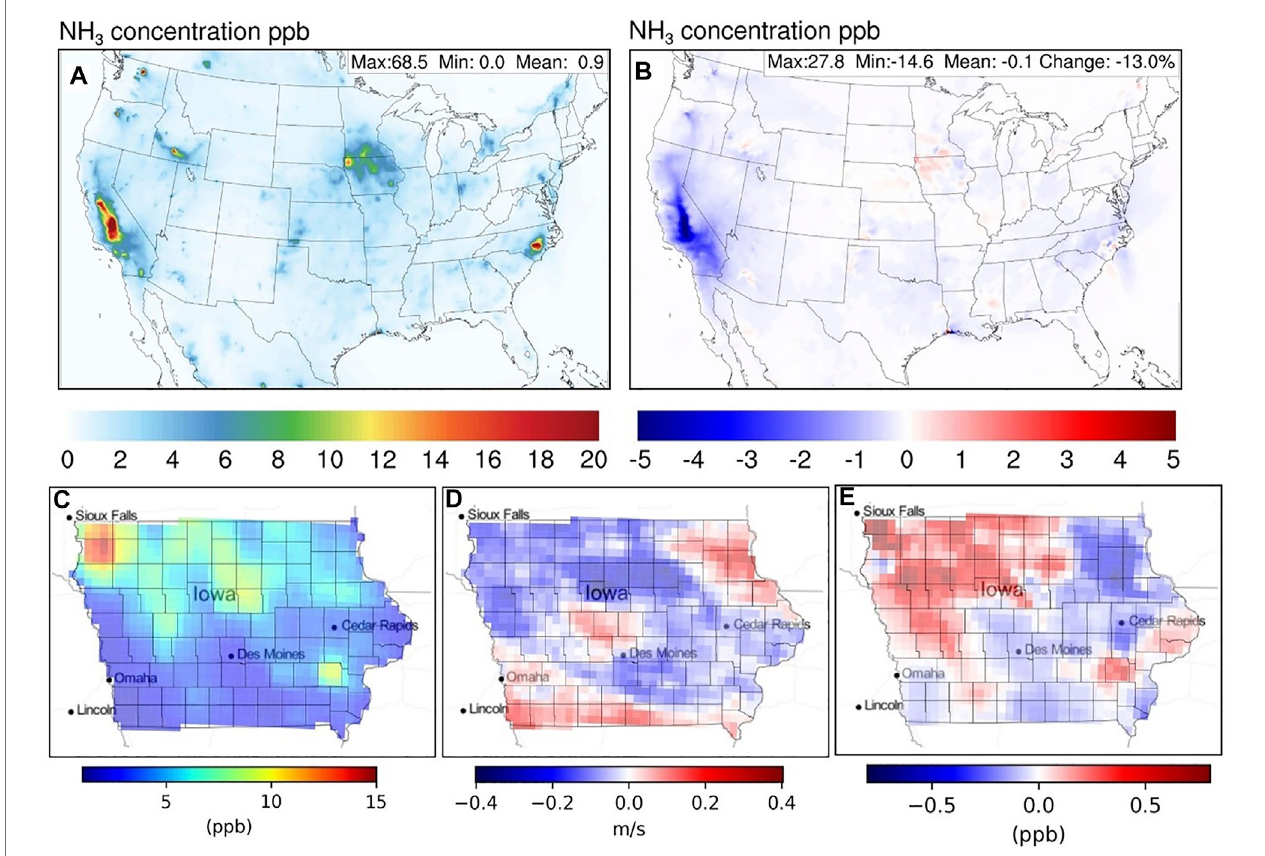
FIGURE 2 | Spatial distribution of time-averaged NH 3 concentration for Base_14 (A) CONUS and (C) State of Iowa. Spatial distribution of differences between UpTk_14 and Base_14 uptake case: (B) NH 3 concentration for CONUS, (D) 10-m wind speed for Iowa and (E) NH 3 concentration for Iowa.